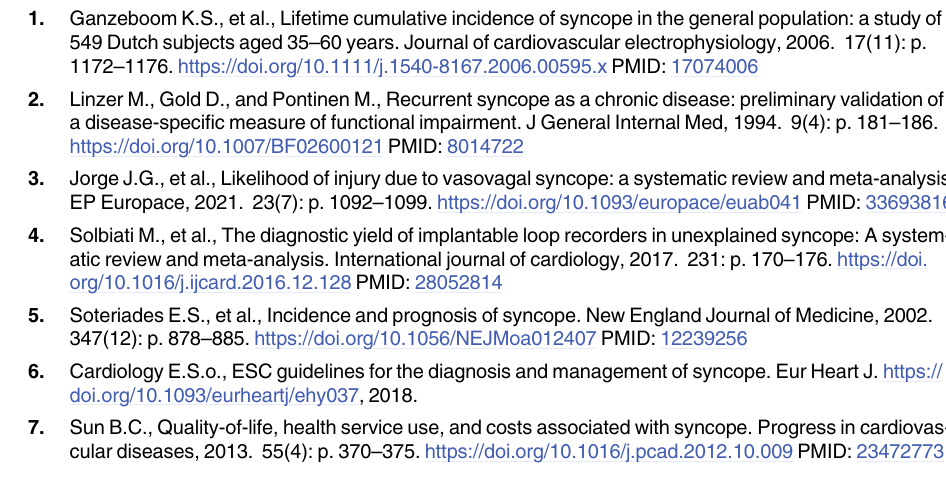
S1 Table. Relative sensitivity to diagnose pause arrhythmias and cost per diagnosed patient with conventional monitoring strategies vs. ICM. Abbreviations: ICM, insertable cardiac monitor; USD, United States